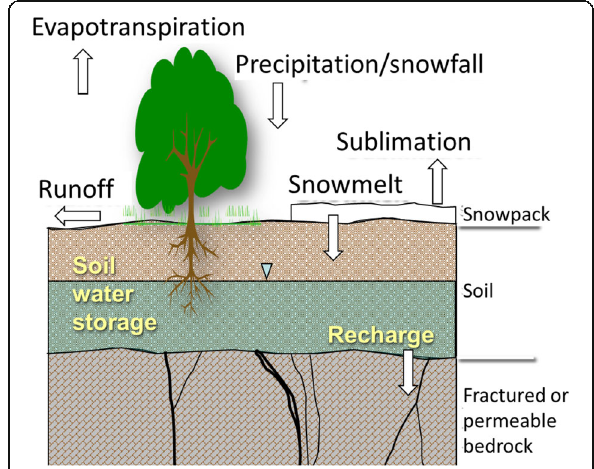
Fig. 2 Schematic of the water balance calculated by the Basin Characterization Model where precipitation = evapotranspiration + runoff + sublimation + recharge + change in soil water content and indicating flow paths of the different